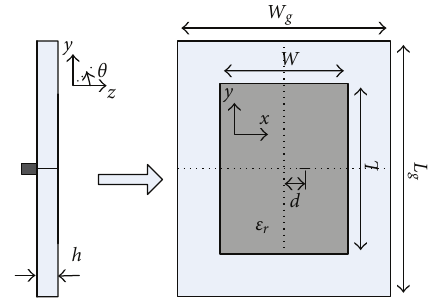
Figure 3: Geometry of a probe feed microstrip